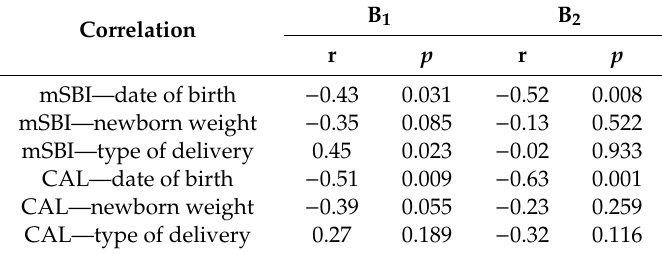
Table 6. Results of the correlation analysis between mSBI and CAL indices and date of birth, newborn weight, and type of delivery in B 1 and B